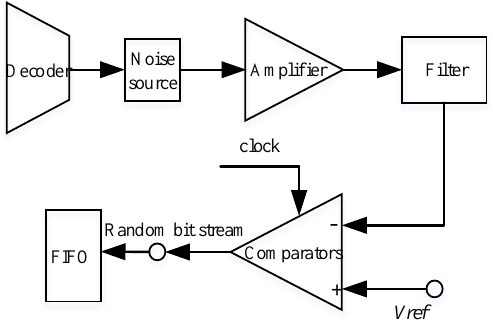
Figure 3. Schematic diagram of noise signal processing circuit.